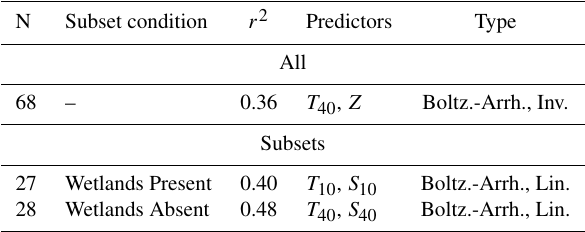
Table 1. Correlation coefficients and predictors of CH 4 emissions for various linear regression models. Boltz.-Arrh.: Boltzmann– Arrhenius function. Inv.: inverse. Lin.: